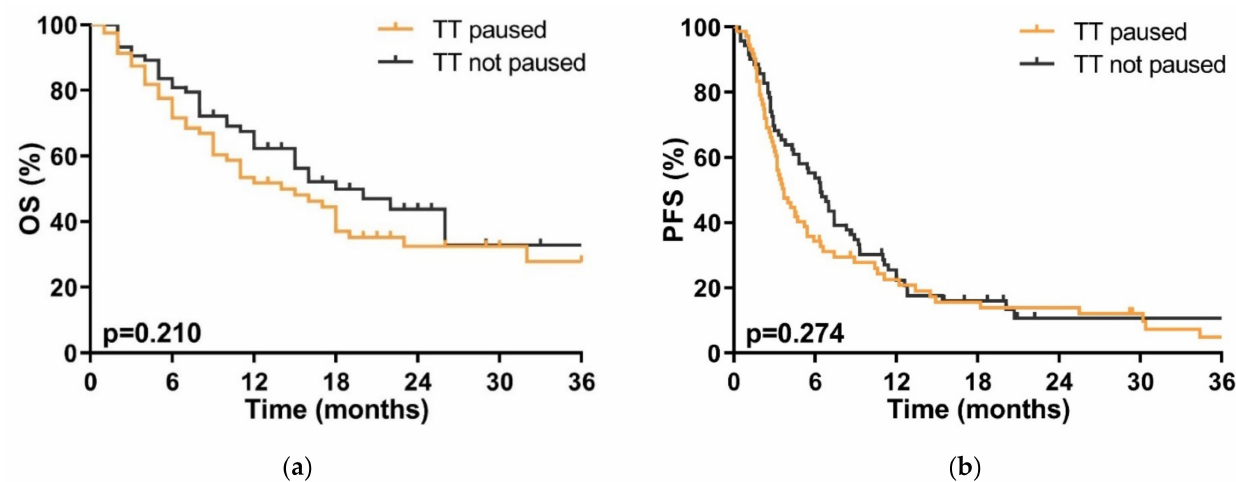
Figure 2. ( a ) Overall survival (OS) of patients where targeted therapy (TT) was interrupted (orange line) or continued (gray line) during stereotactic radiotherapy (SRT). p < 0.05 is statistically significant. ( b ) Progression free survival (PFS) in patients where targeted therapy (TT) was interrupted (orange line) or continued (gray line) during stereotactic radiotherapy (SRT). p < 0.05 is statistically